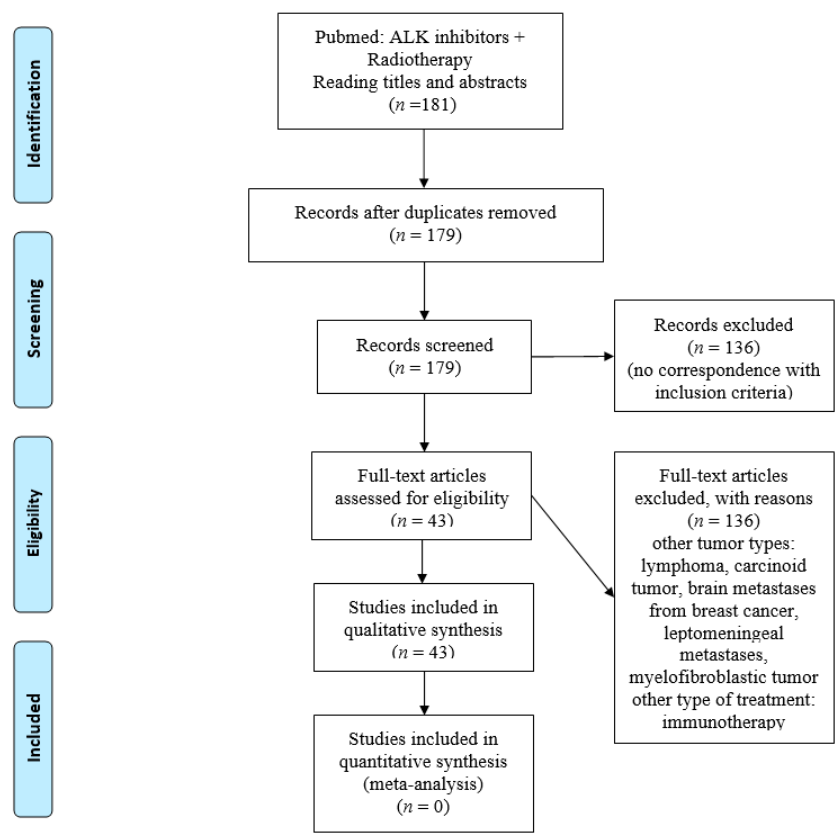
Figure 1. Flow chart of published selected articles in the PubMed database search.